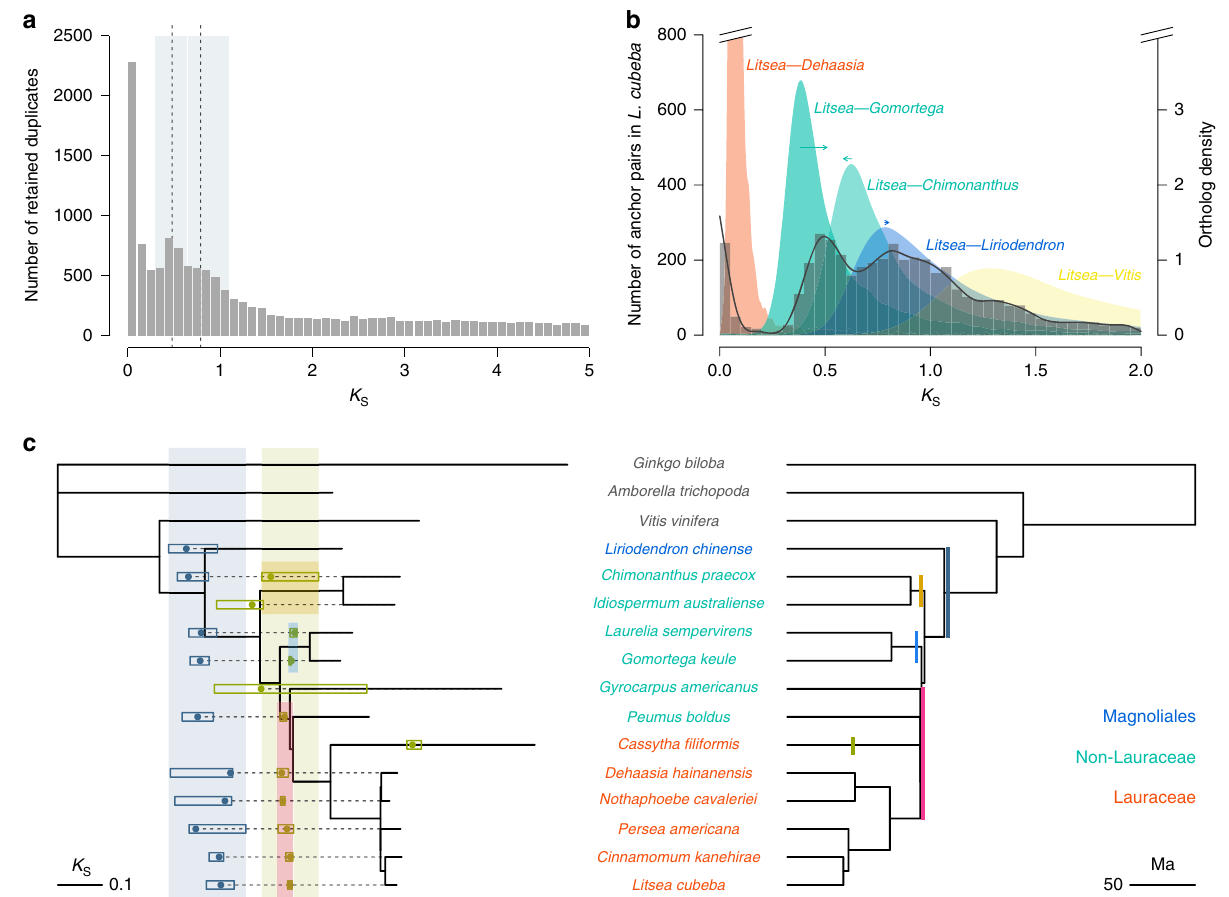
Fig. 2 Whole-genome duplications in Laurales. a K S age distribution for the whole paranome of L. cubeba . Two K S peaks are shown by dotted lines at K S ≈ 0.5 and 0.8 falling in two K S ranges highlighted by two gray rectangles in the background from 0.3 to 0.645 and from 0.645 to 1.1, respectively. b K S age distributions for anchor pairs of L. cubeba (dark gray histogram and line; peaks represent WGD events) and for one-to-one orthologs between L. cubeba and selected Lauralean species and V. vinifera (colored fi lled curves of kernel-density estimates; a peak represents a species divergence event). The arrows in different colors indicate under- (to the left) and overestimations (to the right) of the divergence events and point to the K S values after corrections of different substitution rates in the three comparisons based on that in L. cubeba (see Methods). c The phylogeny of Laurales and Magnoliales with branch lengths in K S units (left) and in absolute divergence time (right). The tree topology and absolute divergence time were retrieved. The K S ages and their 95% con fi dence intervals (CIs) for WGDs identi fi ed from the whole paranome (Supplementary Fig. 9) are shown in dots and rectangles, respectively, on the left phylogeny. Without considering species with only one K S peak in their K S distributions of paralogs, the blue and green rectangles highlight the ranges of 95% CIs of WGDs for the older peaks and the younger peaks, respectively. The red, light blue, and yellow rectangles show the ranges of 95% CIs for three independent WGD events in different lineages of Laurales. Correspondingly, the red, light blue, and yellow bars illustrate the independent WGD events on the right phylogenetic tree with absolute divergence time. The three WGD events occurred at about the same time of the radiation of Lauralean species within ~3 million years. In addition, the green bar denotes a lineage-speci fi c WGD event in C. fi liformis and the blue bar denotes the WGD event before the divergence of Laurales and